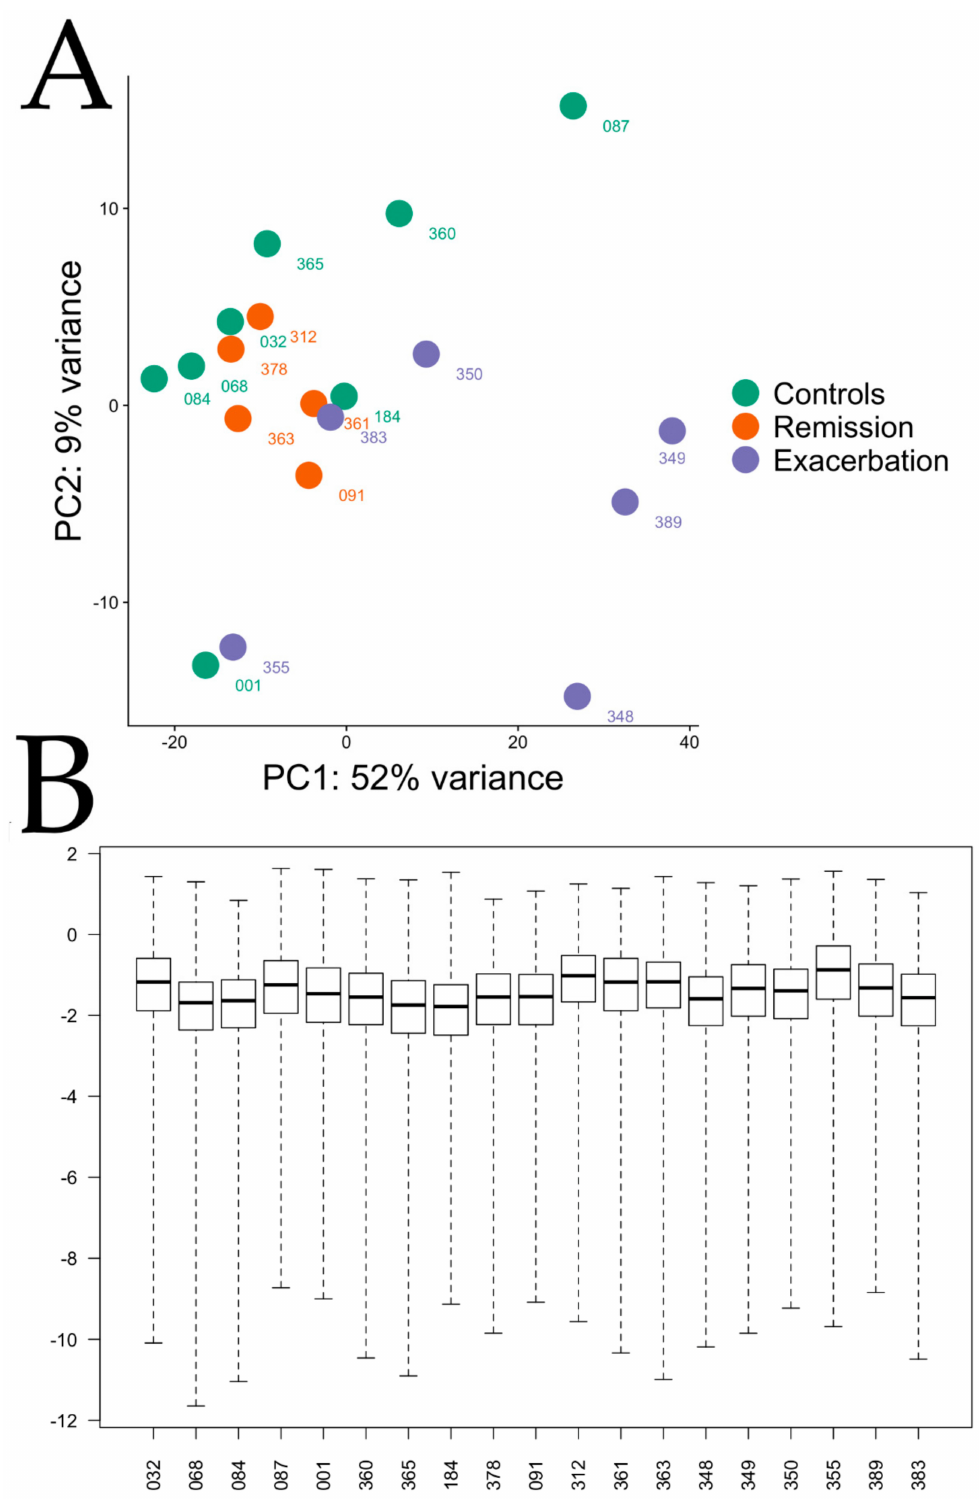
Figure A8. ( A ) Principal component analysis (PCA) plot using the mRNA raw data using the top 500 most variable genes. The labels of the data points indicate sample IDs. ( B ) Boxplots illustrating cook’s distances for each sample across all genes. The numbers in the labels represent sample